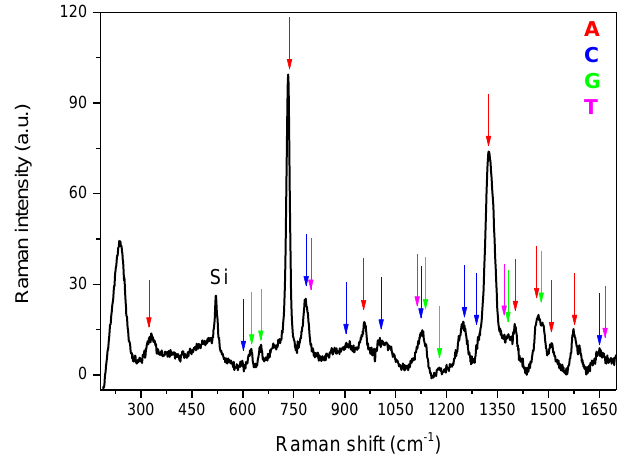
Figure 3. Mean Raman spectra calculated over the map collected on the mixed sample. The various bands, indicated by the arrows, are attributed to the four bases using a colour code.